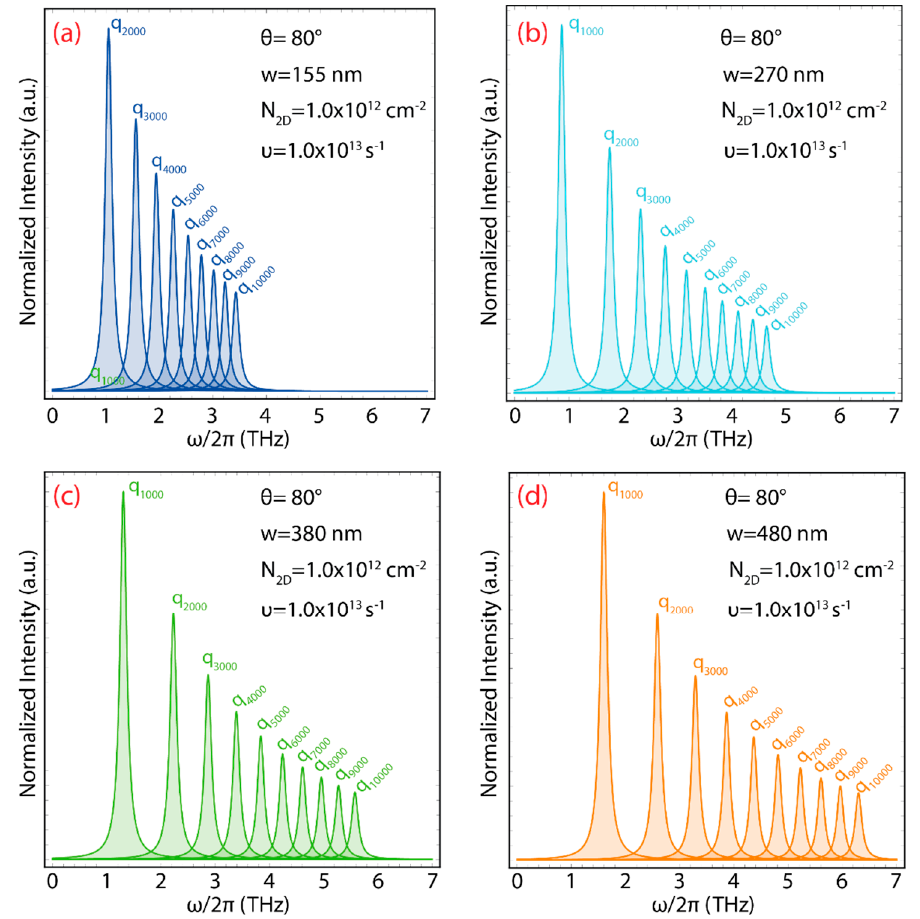
Figure 8. Plasmon excitation lifetime ( ω /2 π ≤ 7 THz) (using θ = 80, N 2 D = 1.0 × 10 12 cm − 2 , ν = 1.0 × 10 13 s − 1 , and v F = 0.829 × 10 6 m s − 1 ) for selected q values from 1000 to 10,000 cm − 1 , with different ribbon widths: ( a ) w = 155 nm, ( b ) w = 270 nm, ( c ) w = 380 nm, and ( d ) w = 480 nm. The plasmon spectra were calculated using the Lorentzian shape function to a maximum value of 1 with FWHM =